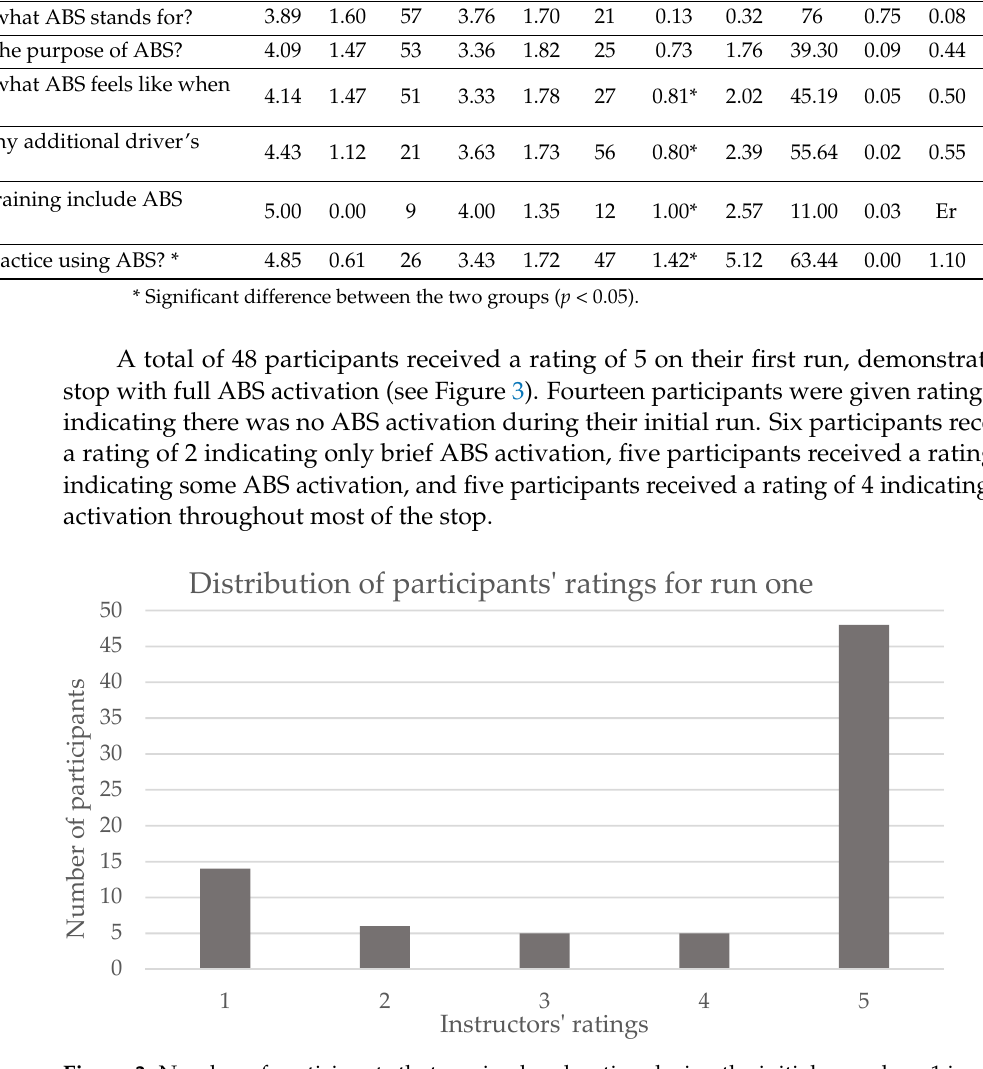
Figure 3. Number of participants that received each rating during the initial run where 1 is no ABS activation, 2 is brief ABS activation, 3 is some ABS activation, 4 is ABS activation throughout most of the stop, and 5 is full ABS activation throughout the entire stop. Table 4. Characteristics of participants that passed (instructor rating of 5) or failed (instructor rating of 1 through 4) during the first run of the ABS exercise.